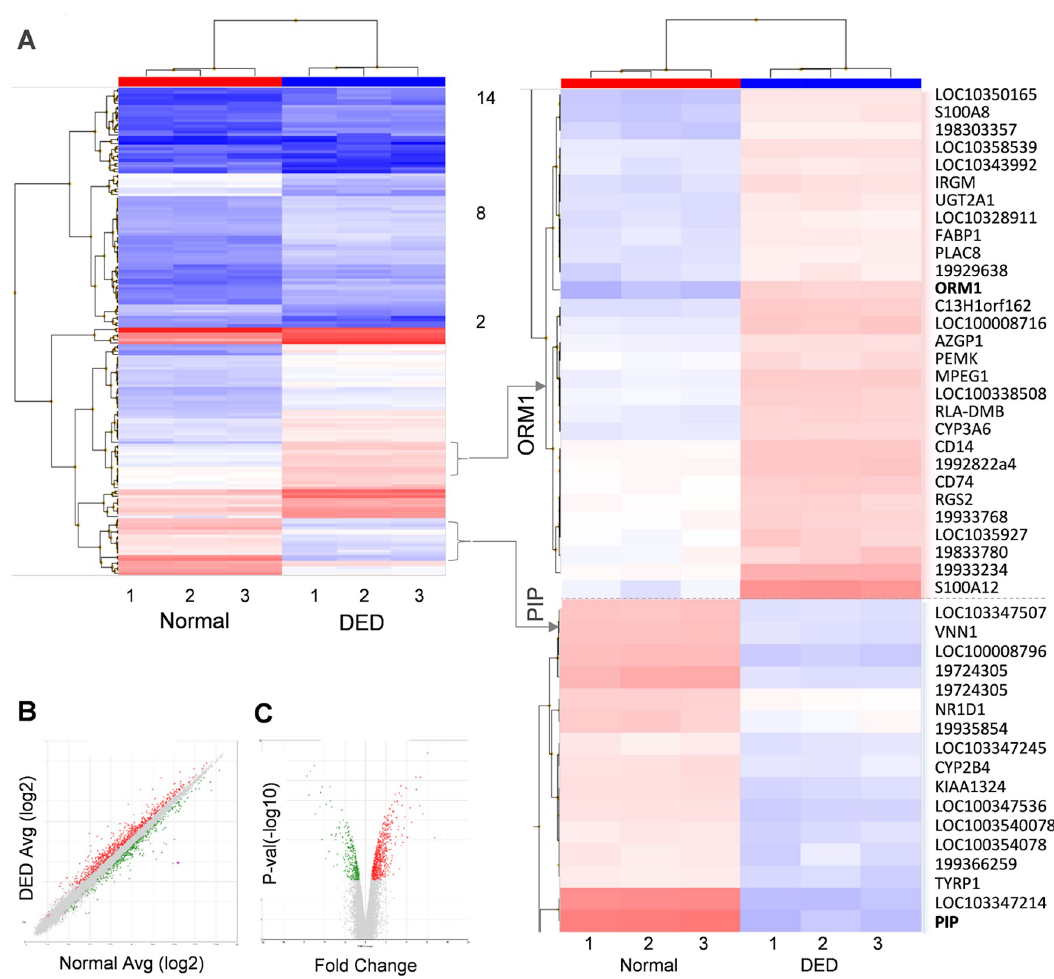
Fig 3. Cluster analysis of gene expression in normal and DED rabbits. A. Heatmap of 831 differentially expressed gene transcripts from Control (left) and DED (right) rabbits (n = 3 each). Red and blue colors denote upregulation and downregulation, respectively. B: Scatterplot representing the data distribution between DED and normal rabbits. C: The volcano plot depicts the statistical significance (p value) versus fold change in geneexpression. Two subclusters of the genes overex-pressed (ORM1) or downregulated (PIP) in DED rabbits compared to normal contols (enlargement to right of